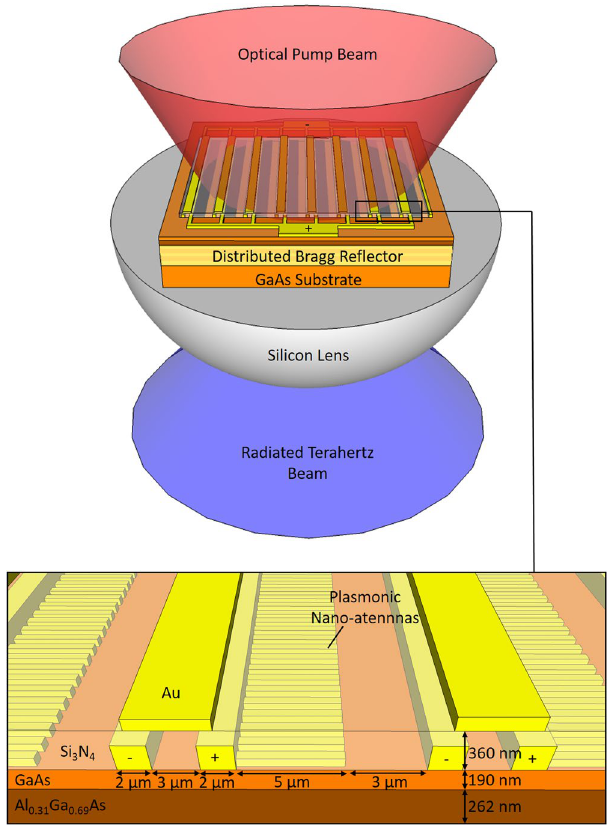
Figure 1. Schematic diagram and operation principle of the presented photoconductive source based on a nanocavity formed by a plasmonic nanoantenna array and DBR